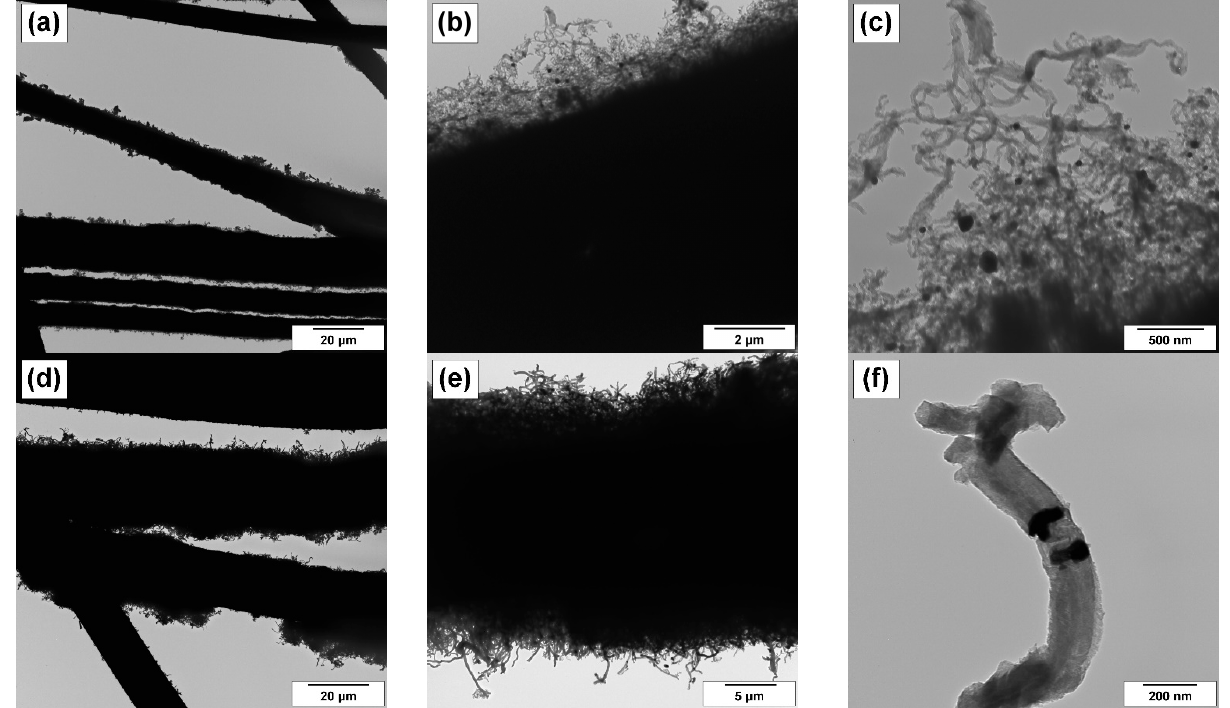
Figure 4. TEM images of the pristine hierarchical samples: ( a – c ) CNF/CMF (Y C = 40 wt%); ( d – f ) CNF/BMF (Y C = 50 wt%). Active particles of metallic Ni catalyzing the growth of CNF are seen in TEM images ( c , f ).